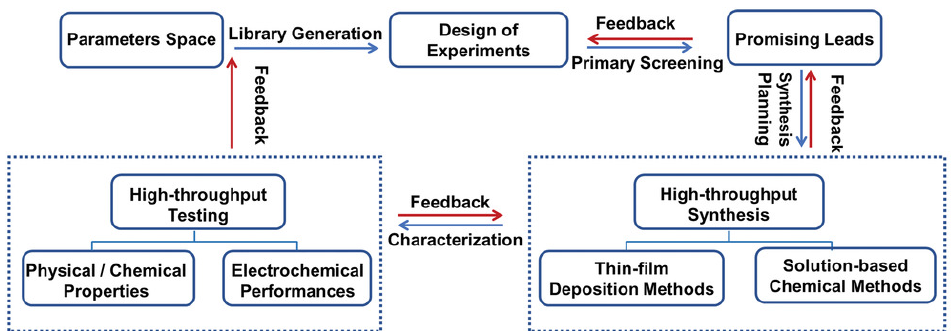
Figure 3. General experimental steps involved in high-throughput screening of high-performance electrocatalysts for CO 2 reduction. Reprinted with permission from Ref. [57]. Copyright 2022, John Wiley and Sons.